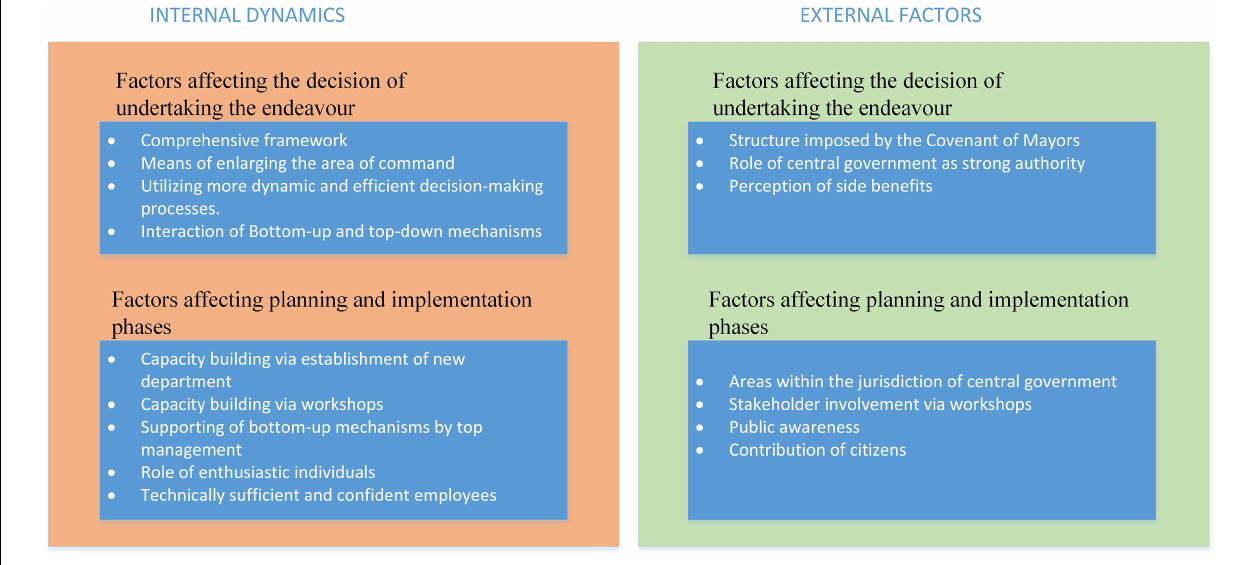
FIGURE 3 | Internal dynamics and external factors affecting the phases of Sustainable Energy Action Plan